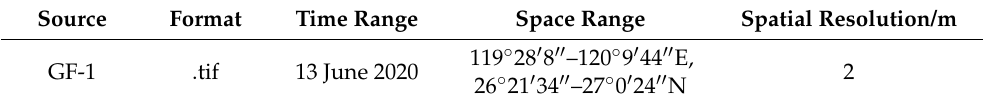
Table 1. Details of experimental data.